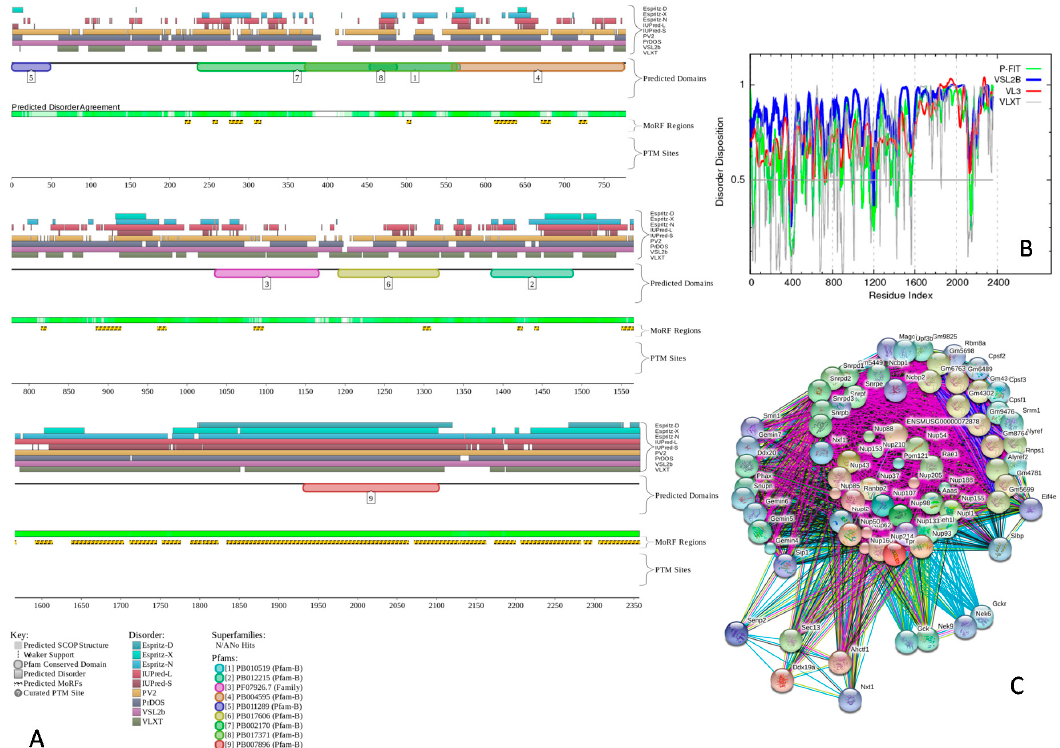
Figure 6. Abundance and functionality of intrinsic disorder in the nuclear pore complex-associated intra-nuclear coiled-coil protein TPR (UniProt ID: Q7M739). ( A ) Evaluation of the functional intrinsic disorder propensity by the D 2 P 2 database (http://d2p2.pro/) [55]. In the corresponding plot, the colored bars at the top are representative of the location of disordered regions obtained from different disorder predictors (including IUPred-L, IUPred-S, Espritz-D, Espritz-N, Espritz-X, PONDR ® VSL2b, PONDR ® VLXT, PV2, and PrDOS). Location of predicted and known domains are shown by numbered colored bars. The white-and-green bars display the agreement in the predicted disorder among the aforementioned predictors, with green parts indicating regions that are disordered by consensus. The yellow bar indicates the location of the predicted disorder-based binding site (MoRF region), whereas red and yellow circles at the bottom of the plots show locations of phosphorylation and acetylation sites, respectively. Vertical dashed lines show actual positions of the phosphorylation sites; ( B ) Evaluation of the per-residue disorder propensity based on predictors from the PONDR family. A thin line at a score of 0.5 represents the disorder threshold between disorder (>0.5) and order (<0.5); ( C ) Analysis of the interactivity of the nuclear pore complex-associated intra-nuclear coiled-coil protein TPR (UniProt ID: Q7M739) by STRING computational platform [78]. STRING produces the network of predicted associations for a particular protein and its interactome. The nodes in this network are proteins, while the predicted or known functional associations are the edges. When predicting the associations, seven types of evidence are used, which are indicated in the resulting network by the differently colored lines. Here, a green line represents neighborhood evidence; a red line—the presence of fusion evidence; a purple line—experimental evidence; a blue line—co-occurrence evidence; a light blue line—database evidence; a yellow line—text mining evidence; a black line—co-expression evidence [78].